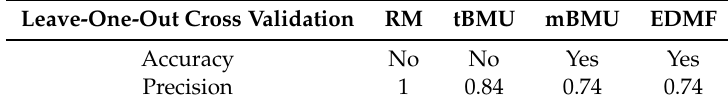
Table 11. Accuracy and precision established using a leave-one-out cross-validation approach for Scenario 2.